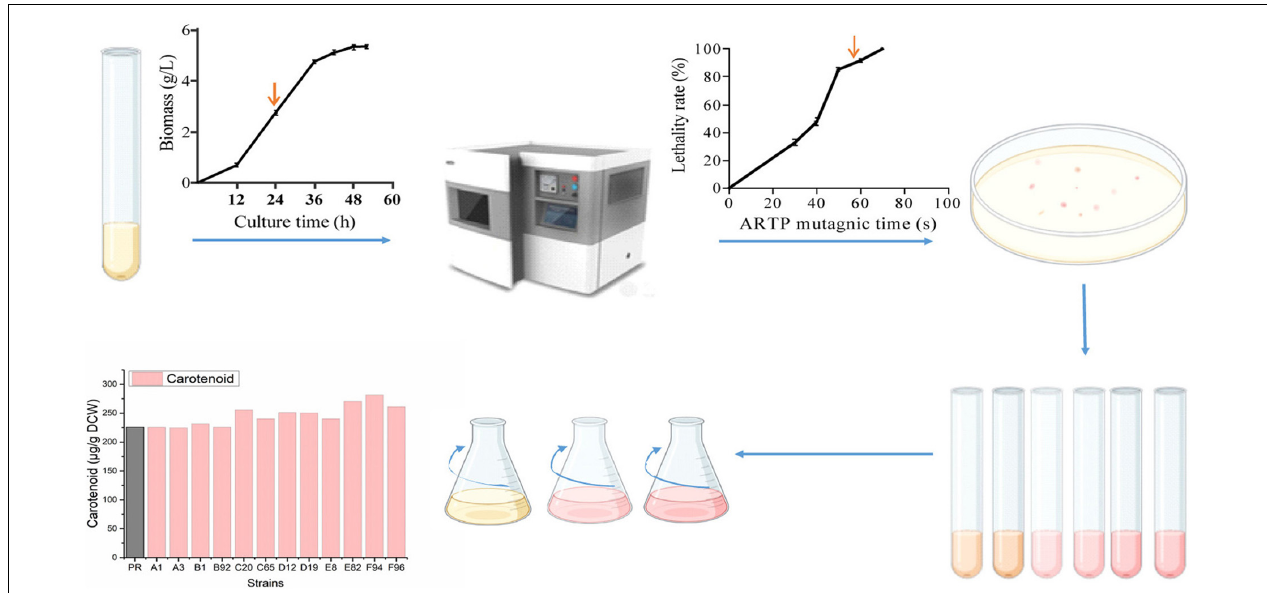
FIGURE 1 | Mutagenesis flow chart. Firstly, the growth curve of wild strain PR was measured in Yeast Extract Peptone Dextrose Medium (YPD), indicating that 24 h is the logarithmic phase. Next, it was determined that the lethality rate was 85% when the ARTP mutagenesis treatment time was 50 s. Then, the strain suspension was spread on a solid medium; large and red colonies were selected. There was a preliminary screening at the test tube level, using carotenoids as indicators. Finally, rescreening was performed at the shake flask level to obtain mutagenic